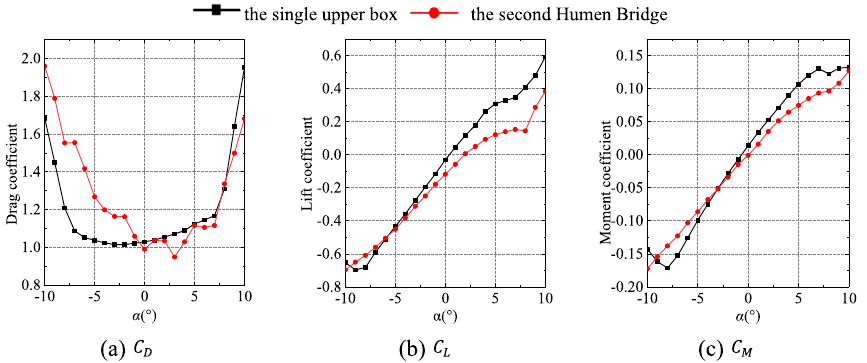
Fig. 5 Aerodynamic coefficients of the upper box and another box